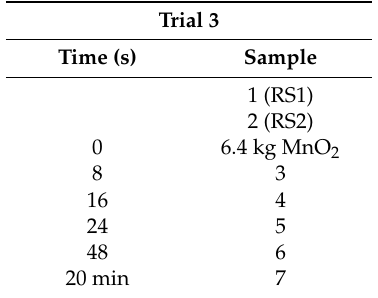
Table 3. Experimental procedure for Trial 3.